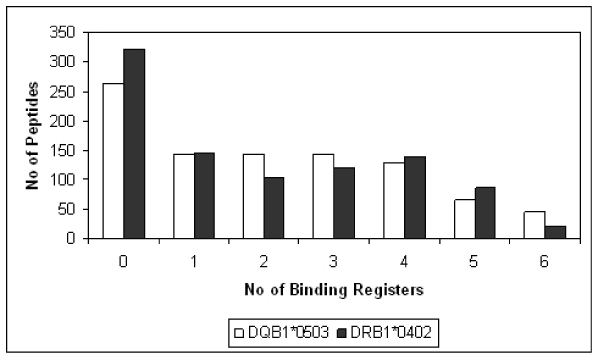
Predicted binding registers for Dsg3 peptides bound to DRB1*0402 and DQB1*0503. The frequency of Dsg3 peptides docked to DRB1*0402 (colored gray) and DQB1*0503 (colored white) is shown as a function of the number of predicted binding registers.